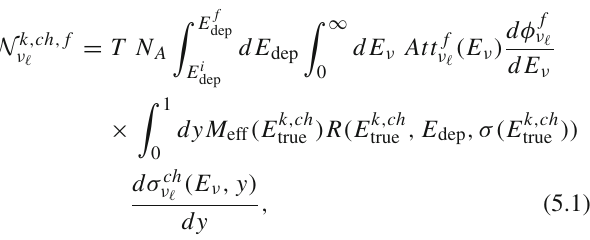
gle LQ) production, at the 95%C.L., at the 13TeV (8TeV) LHC. The region enclosed by the purple line is allowed by the low-energy flavor experiments, at the 2 σ